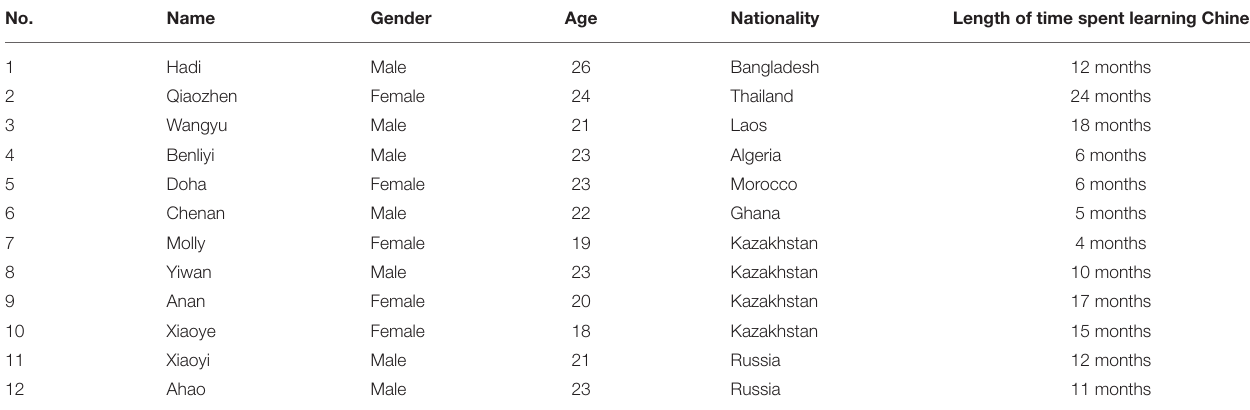
TABLE 1 | Demographic Information of the